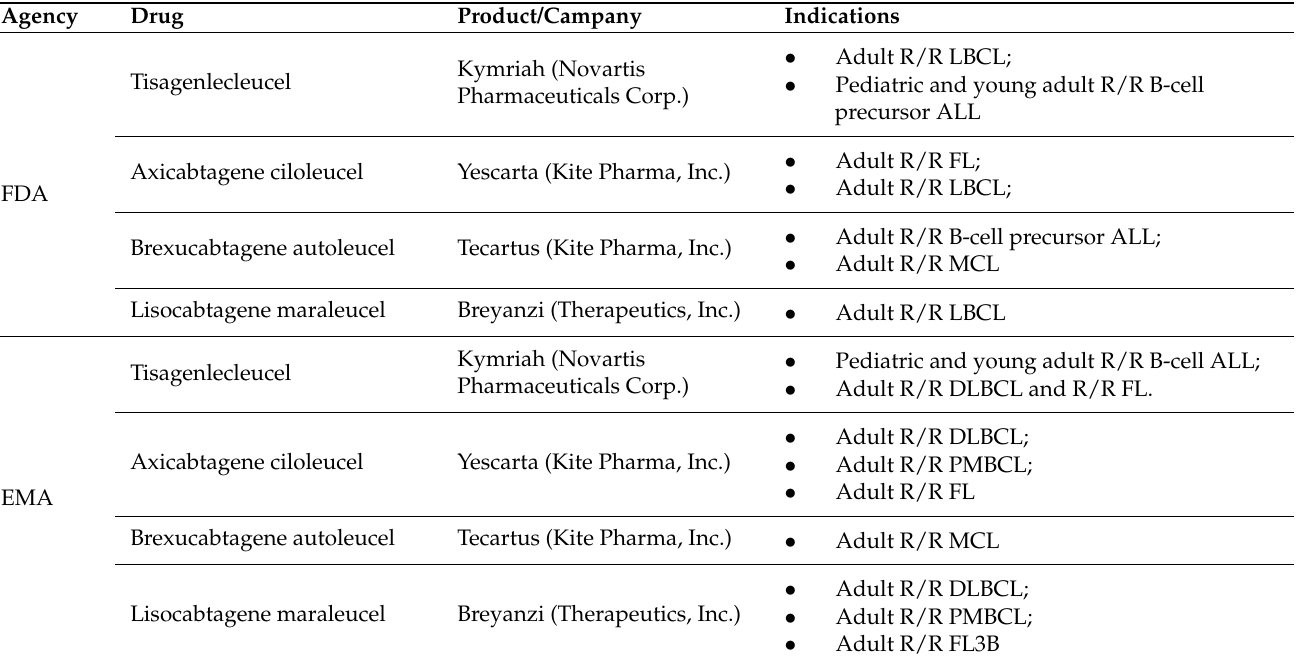
Table 1. List of approved Anti-CD19 CAR-T by the FDA and